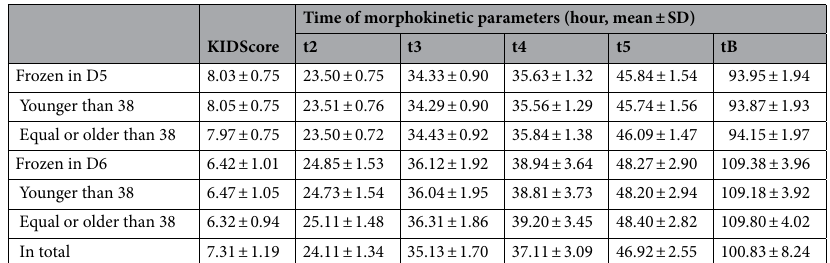
Relationship of morphokinetic characteristics and clinical parameters to euploidy of blasto‑ cysts. Morphokinetic characteristics of time to reach two cells (t2), three cells (t3), four cells (t4), five cells (t5), and time to reach blastocyst (tB) of blastocysts frozen on D6 were significantly delayed compared to blas- tocysts frozen on D5 ( P < 0.05), and the KIDScore of D5 blastocysts was higher than that of D6 blastocysts ( P < 0.05) (Table 3). In all blastocysts, Spearman correlation of euploidy to t2, t3, t4, t5, tB, KIDScore, female age, clinical indication of PGT-A, Gardner grade of blastocysts, and the number of embryonic frozen days are presented in Table 4. t2, t3, t4, t5, and tB, female age, and the number of embryonic frozen days were significantly and negatively correlated with euploidy in all blastocysts ( P < 0.05), indicating that the possibility of euploidy increased as t2, t3, t4, t5, tB, female age, and the number of embryonic frozen days decreased. KIDScore and Gardner grades were significantly and positively correlated with the euploidy of blastocysts, suggesting that the possibility of euploidy increased as the KIDScore and Gardner grade increased ( P < 0.05). In addition, there was no significant correlation between euploidy and the clinical indication for PGT-A ( P > 0.05). Two-logistic regression was used to analyse the relationship between euploidy and t2, t3, t4, t5, tB, KID score, female age, Gardner grade, and number of embryonic frozen days (Table 5). In all blastocysts, the result